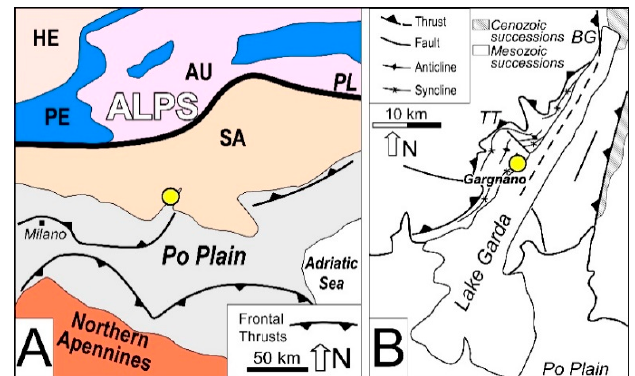
Figure 1. ( A ) Tectonic map of the central part of the Alps (modified after [49]). North-vergent collisional belt (North of Periadriatic Lineament): Austroalpine (AU), Helvetic–Dauphinois (HE), Penninic (PE). Southern Alps (SA) rest South of Periadriatic Lineament. Periadriatic lineament (PL) and fronts of buried thrusts in the Po Plain are shown. ( B ) Structural setting of the Lake Garda region: (TT) Tremosine–Tignale and (BG) Ballino–Garda fault systems (modified after [49]). The yellow dots in ( A , B ) indicate the study area.